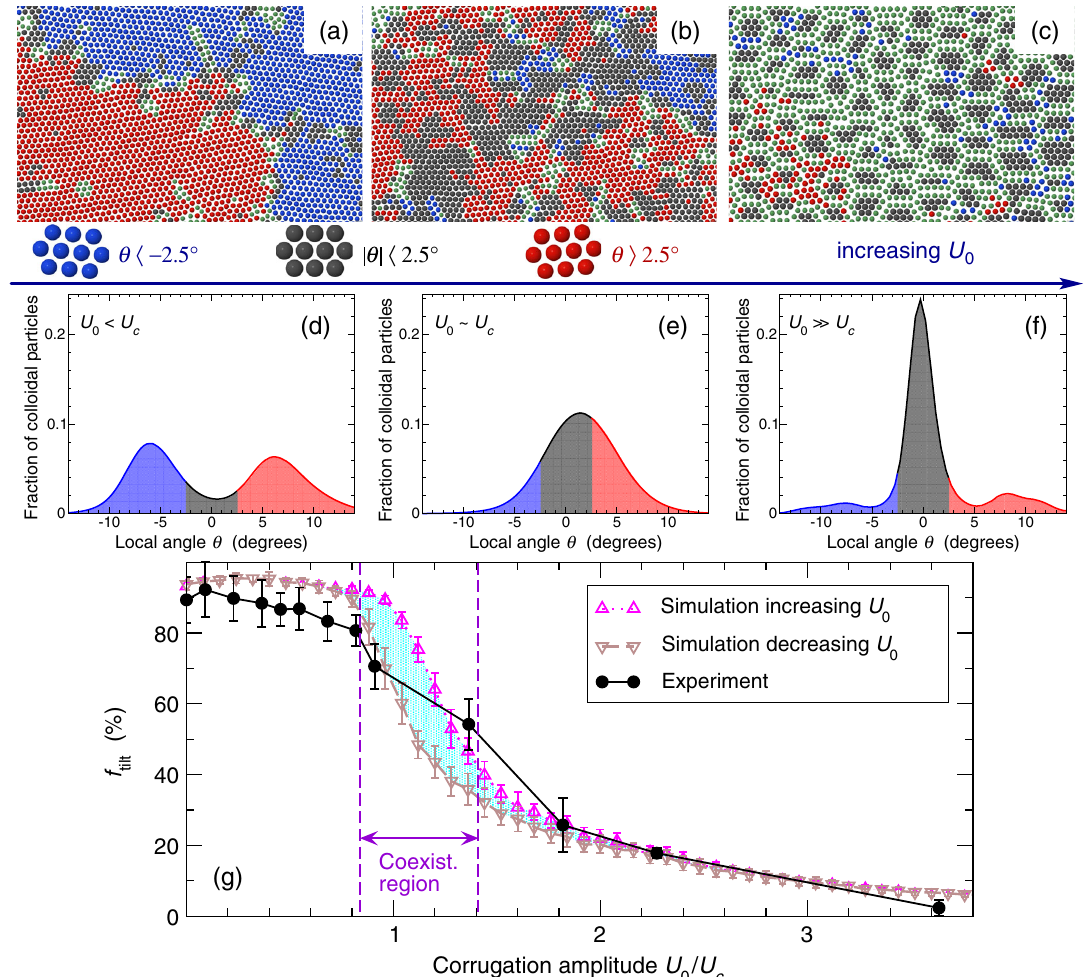
FIG. 2. Structural response and emergence of coexistence region. (a) – (c) Configurations representative of (a) the superlubric phase, (b) the coexistence region, and (c) the pinned phase. The color scheme follows the local bond-orientation angle θ i relative to the crystalline directions of the corrugation potential (S.M.). (d) – (f) The local-angle distribution, obtained for corrugation (d) U 0 ¼ 0 . 63 U c (unpinned, i.e. superlubric configuration), (e) U 0 ¼ 1 . 25 U c (coexistence region), and (f) U 0 ¼ 11 . 3 U c (statically pinned region). (g) Corrugation dependence of the fraction f of tilted (red þ blue) colloids. In the simulations the presence of hysteresis, due to slow tilt numerical equilibration, helps identify the coexistence region, characterized by a change of slope in